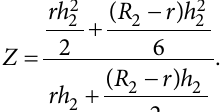
Figure 3. Cross-section of the cone vertically